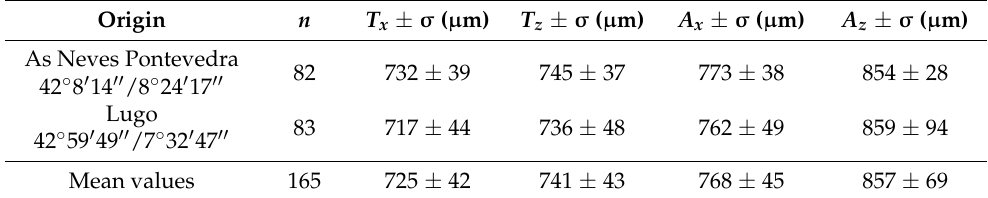
Table 1. Determination of the mean size of the thorax ( T ), in dorsal ( x ), and lateral ( z ) view and of the abdomen ( A ), in dorsal ( x ), and lateral ( z ) view of the sample of n adults that emerged in the